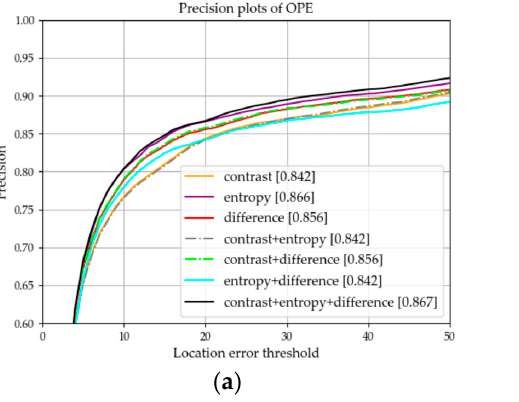
Figure 3. Performances of different channel selection strategies. ( a ) Precision plots of different channel selection strategies; ( b ) Success plots of different channel selection strategies.